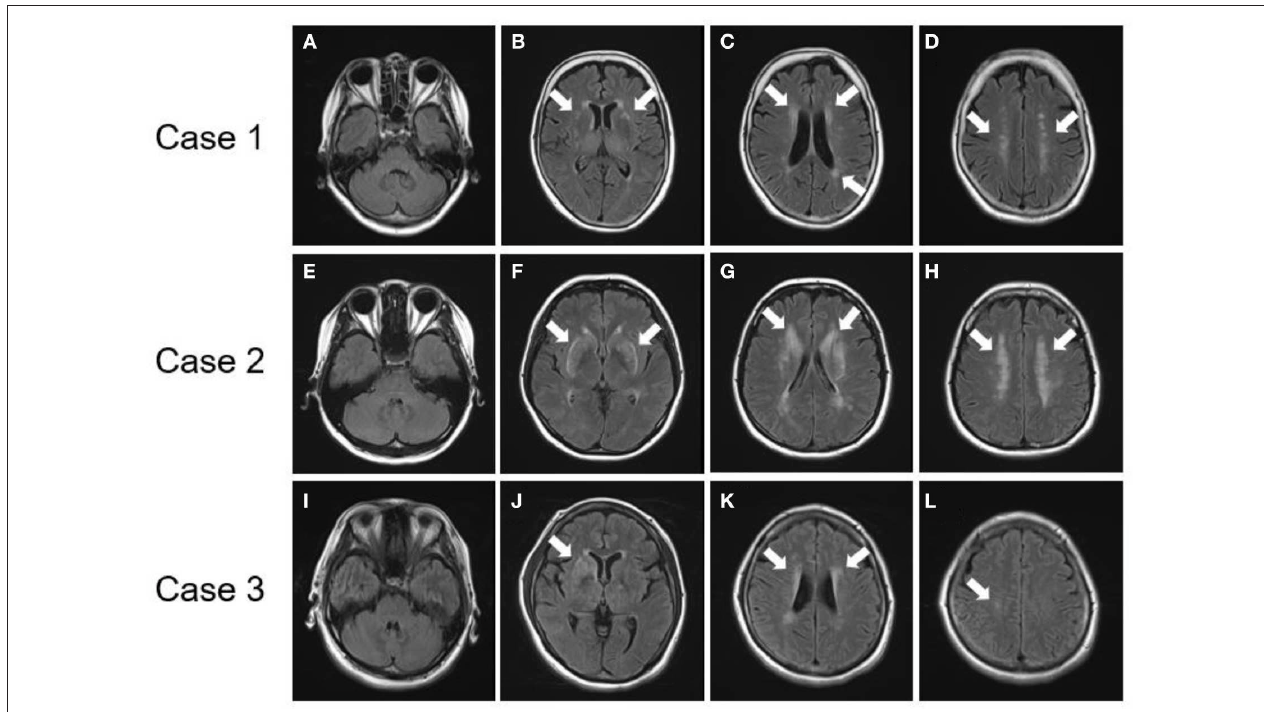
FIGURE 3 | Brain MRI findings of patients with NOTCH3 mutation. (A–D) FLAIR images of a patient with a NOTCH3 p.R75P mutation (Case 1). (E–H) FLAIR images of a patient with a NOTCH3 p.R75P mutation (Case 2). (I–L) FLAIR images of a patient with a NOTCH3 p.R75P mutation (Case 3). (A,E,I) No patients presented lesions on their temporal pole lobes. (B,F,J) Arrows indicate hyperintensity lesions at external capsules. (C,D,G,H,K,L) Arrows indicate periventricular